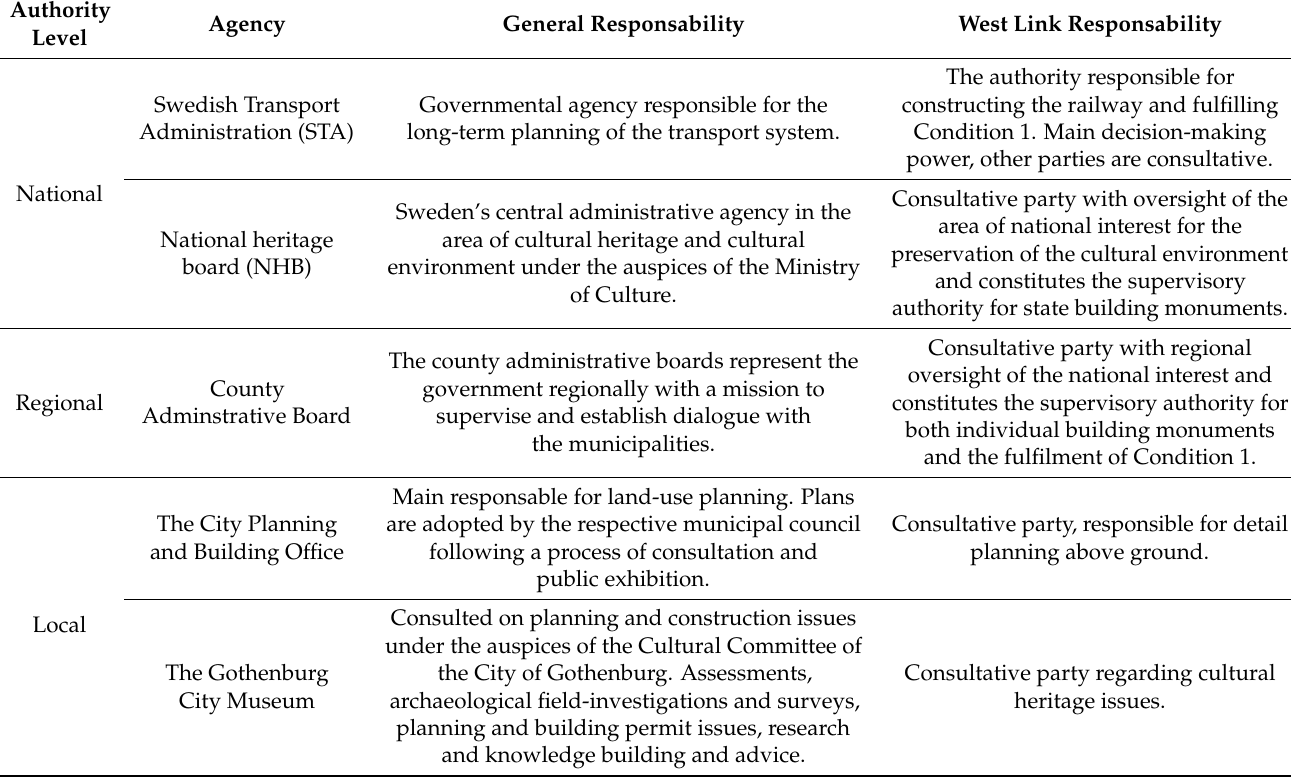
Table 2. Stakeholders and their respective responsibilities in the West Link infrastructure